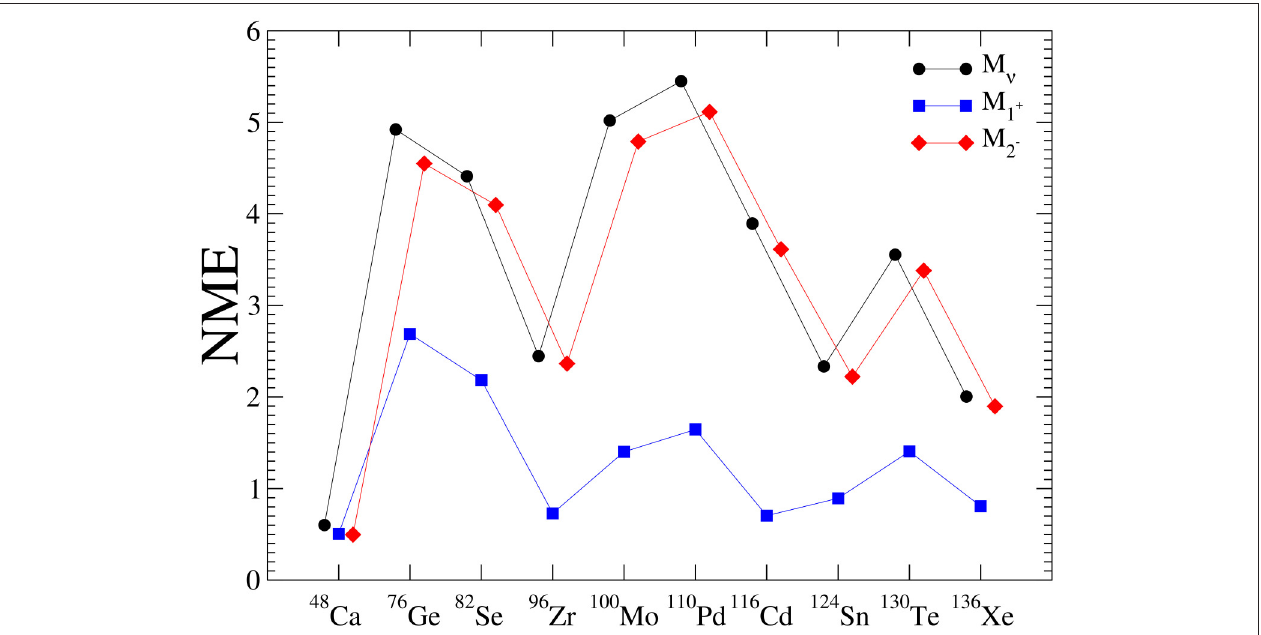
FIGURE 1 | A comparison of the nuclear matrix elements M 1